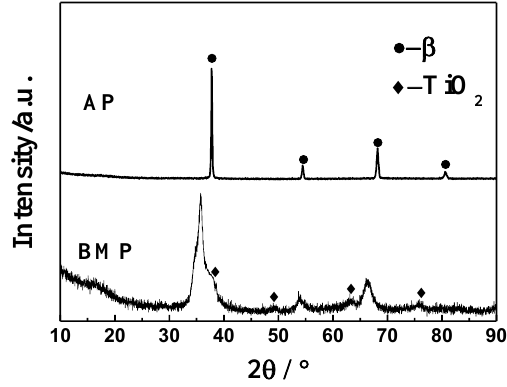
Figure 2. XRD patterns of atomized and ball-milled powders.